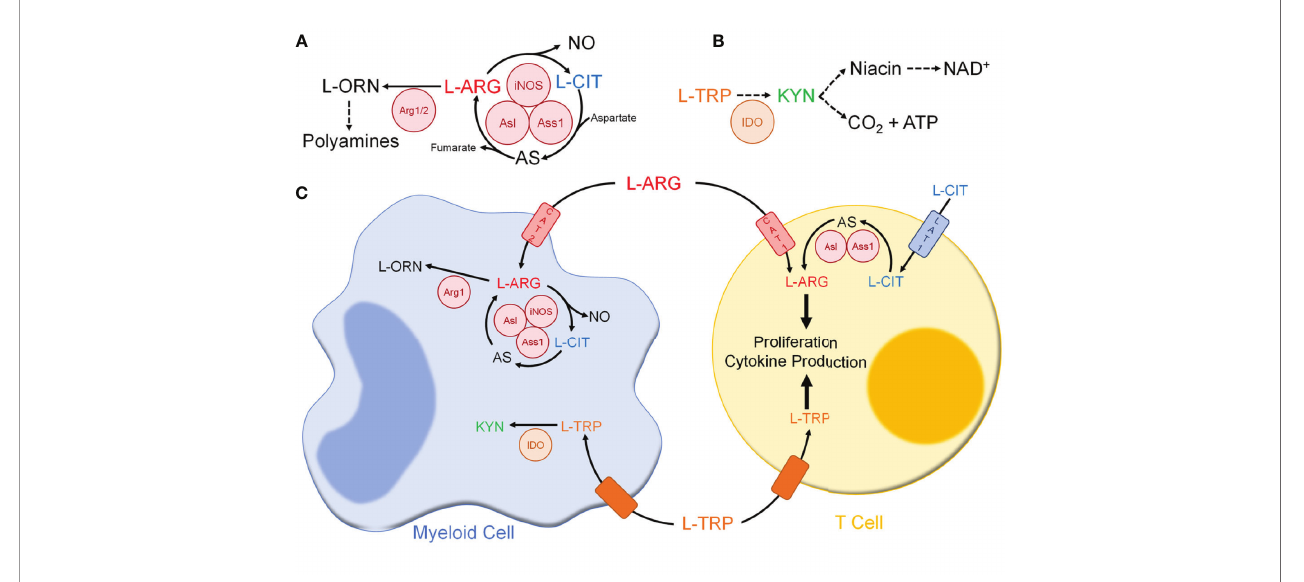
FIGURE 2 | Immune cell amino acid metabolism following mycobacterial infection. (A) L-ARG metabolism pathway in immune cells. (B) L-TRP metabolism pathway in immune cells. (C) Amino acid metabolism between myeloid and T cells. Abbreviations: L-ARG, L-arginine; L-CIT, L-citrulline; L-ORN, L-ornithine; iNOS, inducible nitric oxide synthase; Ass1, argininosuccinate synthase 1; Asl, argininosuccinate lyase; Arg1/2, arginase 1/2; L-TRP, L-tryptophan; KYN, L-kynurenine; IDO, indolamine 2,3-dioxygenase; CAT1, cationic amino acid transport 1; CAT 2, cationic amino acid transporter 2; LAT1. L-type amino acid transporter